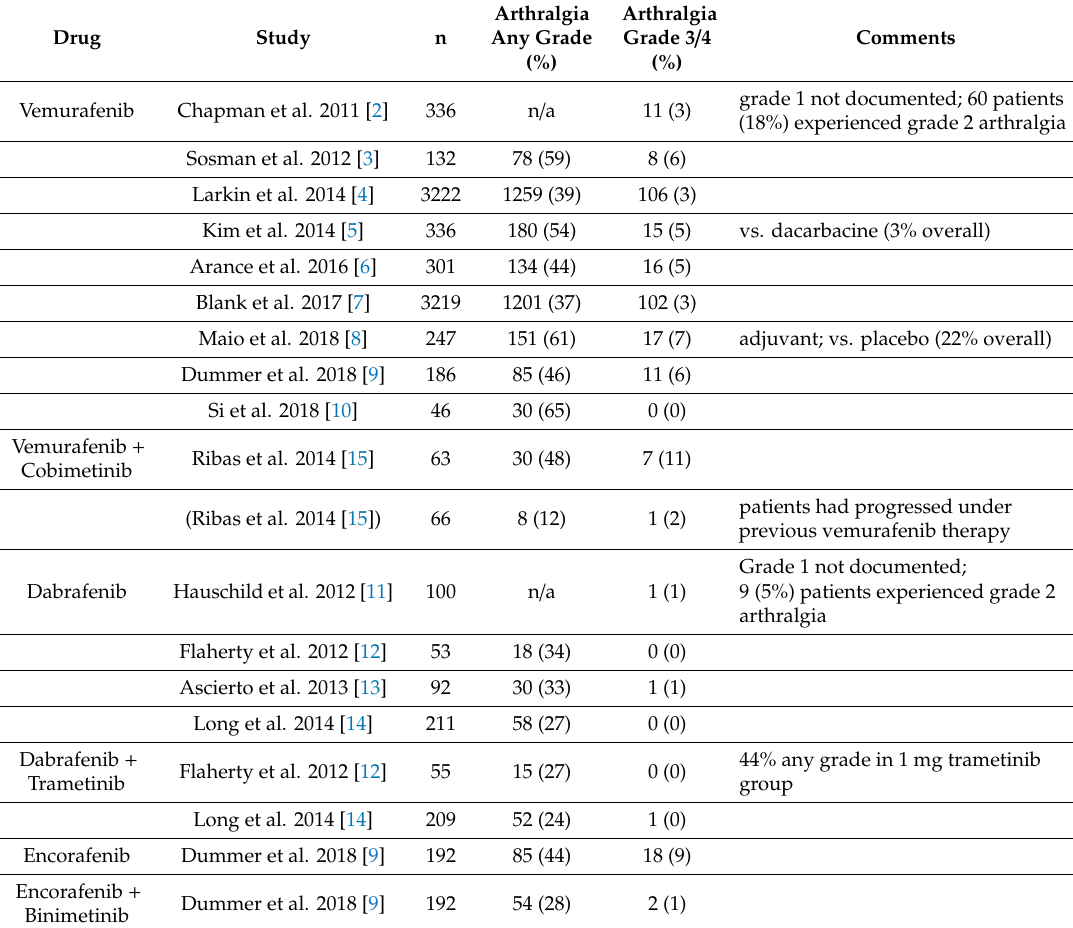
Table 1. Reported incidence of arthralgia in major publications on BRAF inhibitors (BRAFi) therapy. Drug Study